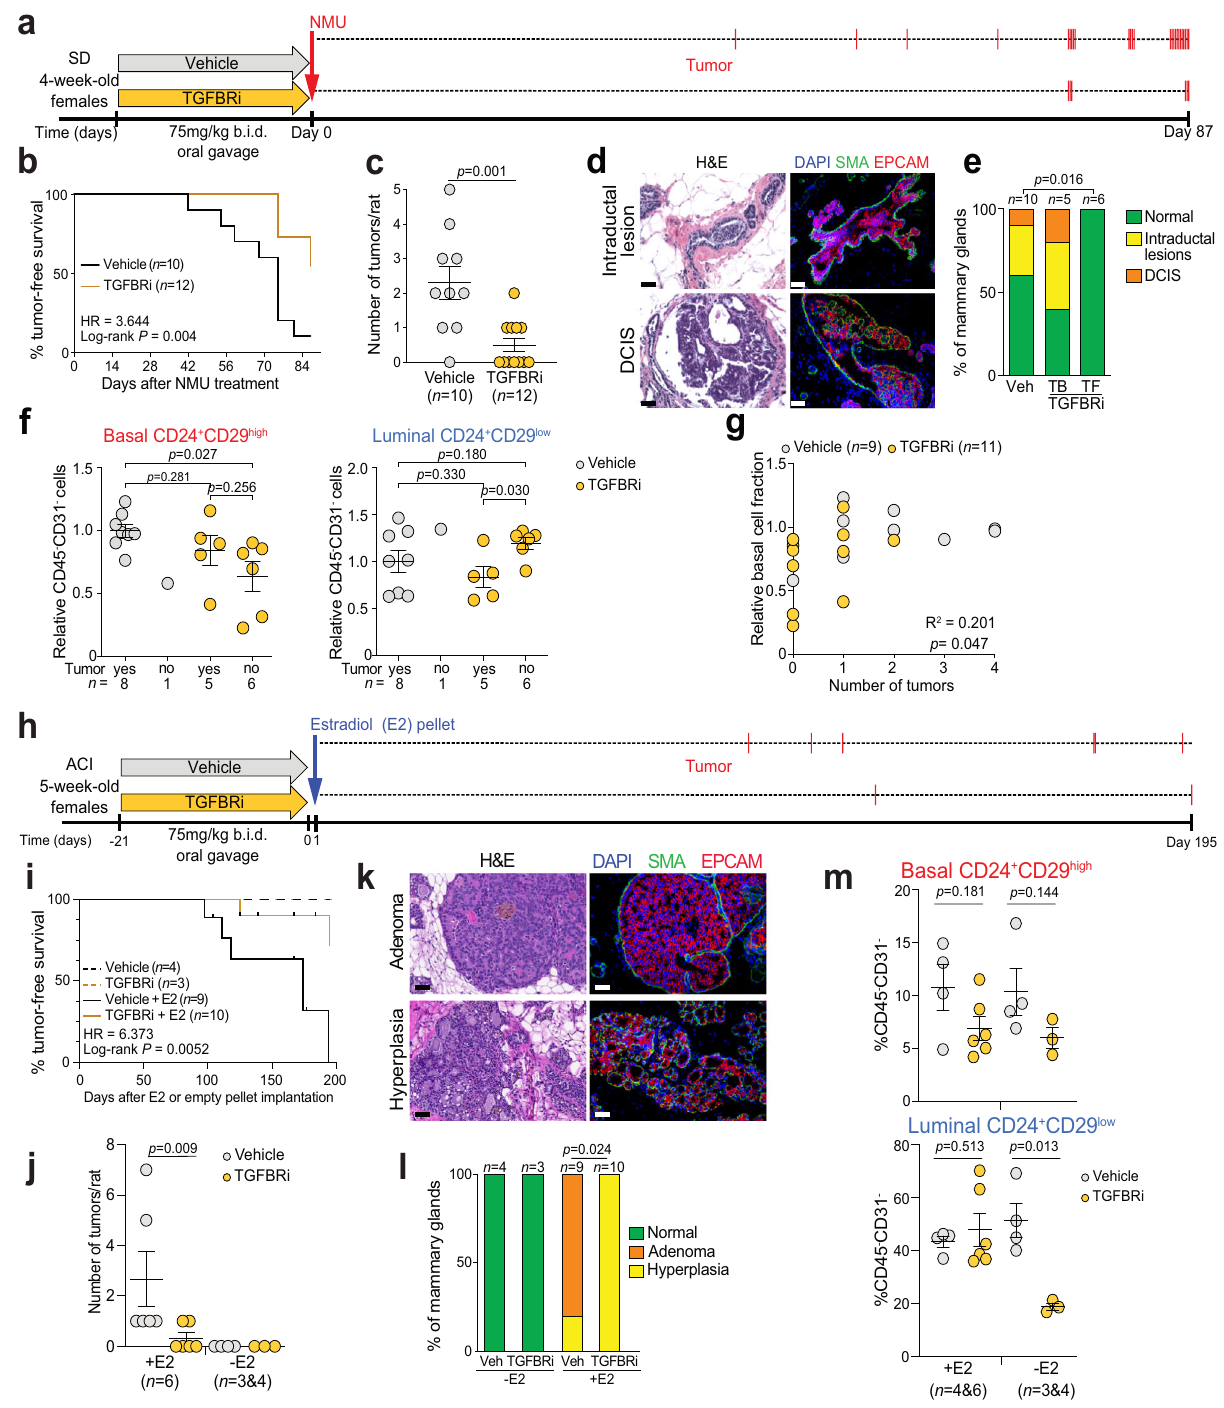
Fig. 2 | Peripubertal TGFBRi treatment prevents mammary tumor initiation. a SchematicoutlineofexperimentaldesignofNMU-inducedtumorsinSDrats.Red barsindicatethedetectionofanewtumor. b Kaplan – Meiertumor-freesurvivalplot for SD rats. c Tumor burden per SD rat. d , e Representative images ( d ) and quan- ti fi cation ( e ) of microscopic lesions in mammary glands without palpable tumors. f Quanti fi cation of basal (CD24 + CD29 high ) and luminal (CD24 + CD29 low ) mammary epithelialcellswithintheCD31 − CD45 − cellpopulationfrom fl owcytometricanalysis in SD rats. g Relationship between the relative fraction of basal cells and tumor burden for all animals. h Schematic outline of experimental design of E2-induced tumors in ACI rats. Redbarsindicate the detectionofa new tumor. i Kaplan – Meier